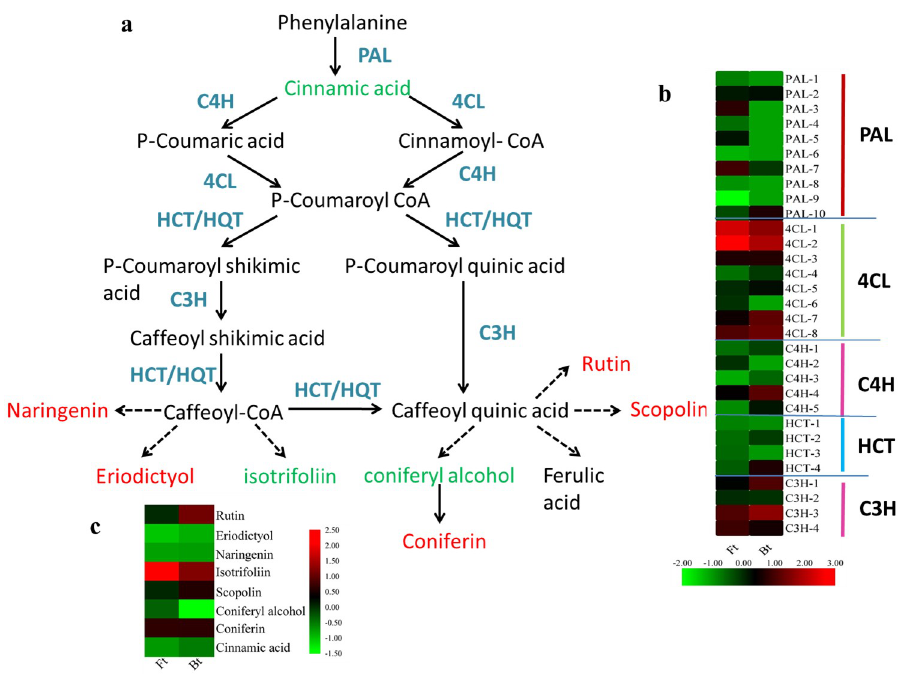
Fig 7. Biosynthetic pathway of chlorogenic acids. (a): Metabolic pathway map of integrative chlorogenic acids biosynthesis in L . macranthoides . Red indicates an increase in content, and the blue indicates a decrease in content. (b): Heat map of changes in transcripts in chlorogenic acids biosynthesis. (c): Heat map of changes in metabolites in chlorogenic acids biosynthesis. Upregulated (red) and downregulated (green) genes and metabolites are indicated. Ft indicates the flowering type, Bt indicates closed bud type and Bt1000 indicates MeJA-treated closed bud type. https://doi.org/10.1371/journal.pone.0251390.g007 does not stay on CGAs, and the next step product is synthesized under the catalysis of other enzymes. In our experiment, a total of 8 DAMs were confirmed based on UPLC-MS, as shown in Fig 7c. Apart from cinnamic acid, the 7 DAMs are downstream of the phenylalanine biosyn- thesis pathway. Upstream of CGA synthesis, the ion abundance of eriodictyol and naringenin in Ft was significantly higher than that in Bt. Compared with Bt, the ion abundance of Rutin, Coniferin and Scopolin in Ft was up-regulation (Fig 7c). To some extent, although the upstream genes of CGAs biosynthesis are upregulated in Ft, due to the generation of caffeoyl- COA and CGAs are catalyzed by corresponding enzymes to synthesize downstream sub- stances, resulting in the ion abundance of CGAs in Ft being significantly lower than that of Bt. Table 3. Ion abundance of chlorogenic acids in Bt, Ft and Bt1000.